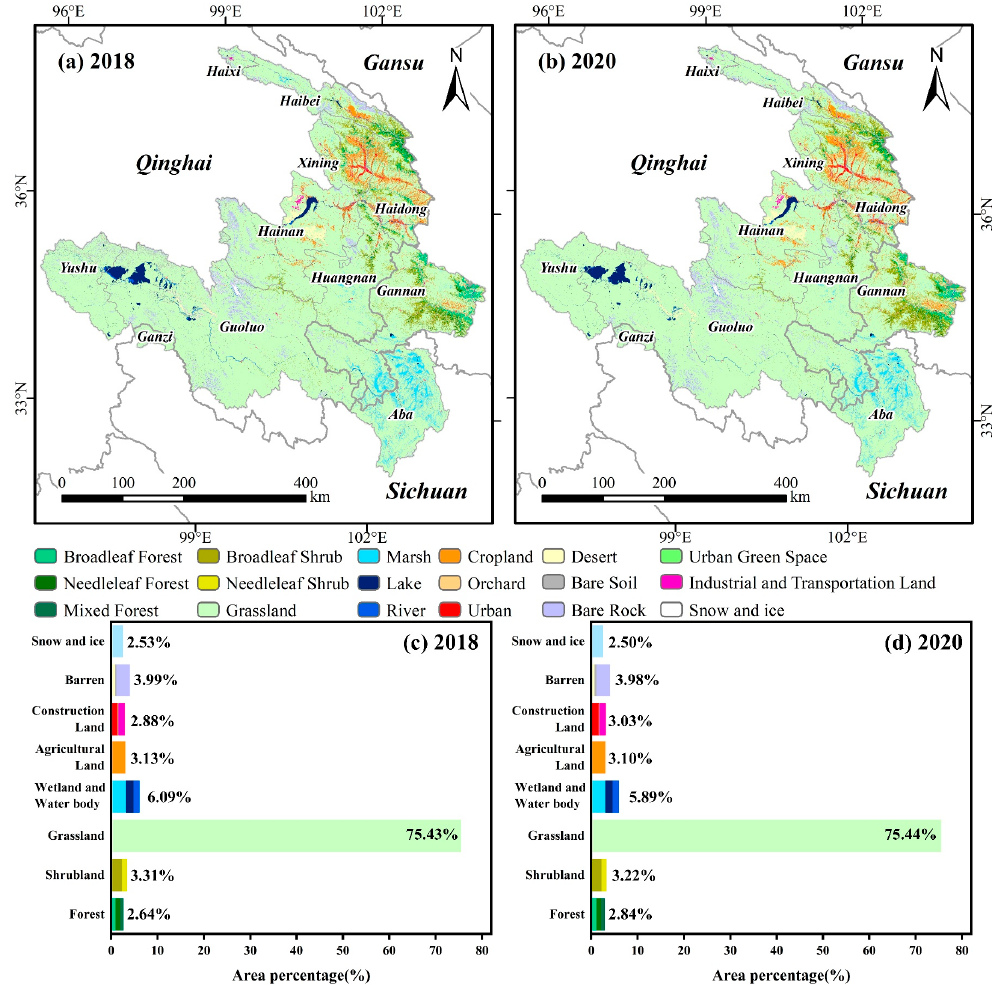
Figure 9. Spatial distribution of LULC second-degree classes in the study area in 2018 ( a ) and 2020 ( b ); area share of different LULC types in 2018 ( c ) and 2020 ( d ).